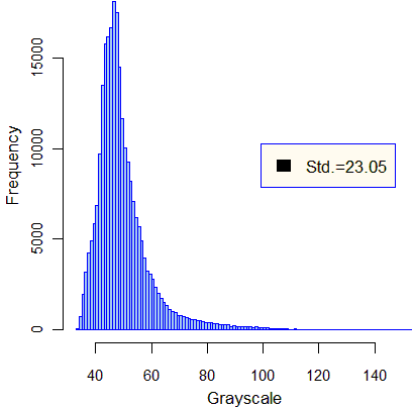
Figure 3. Grayscale histogram of the initial image